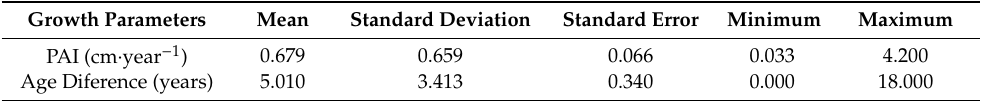
Table 3. Descriptive statistics estimated for periodic annual increment and tree age di ff erence, from 101 pairs of L. azorica (Seub.) Franco wood cores collected at tree base and at breast height. Growth Parameters Mean Standard